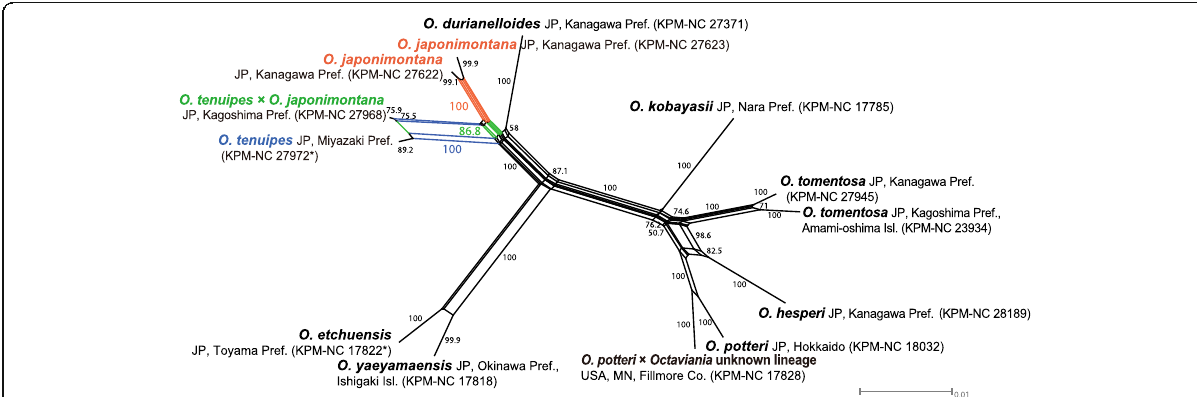
Fig. 3 Phylogenetic network of the combined multilocus (ITS and LSU nrDNA, RPB1 and TEF1 ) dataset of O. subg. Octaviania constructed by the NeighborNet method and displayed with the EqualAngle algorithm (Dress and Huson 2004). BS values below 50% are not shown. Holotype materials are designated with asterisks